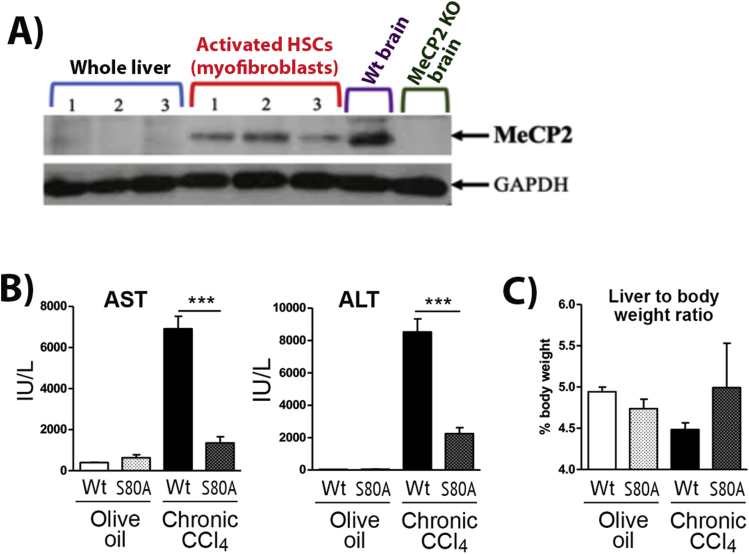
(A) Western blot for MeCP2 in whole liver or activated HSCs; MeCP2 WT and KO brain was used as positive or negative control, respectively. (B) Liver–to–body weight ratio in WT and MeCP2S80A mice treated with chronic CCl4 or vehicle. Error bars in relevant panels represent mean ± SEM. ***P < .001. (C) Assessment of serum transaminases alanine transaminase (ALT) and aspartate transaminase (AST). KO, knockout.